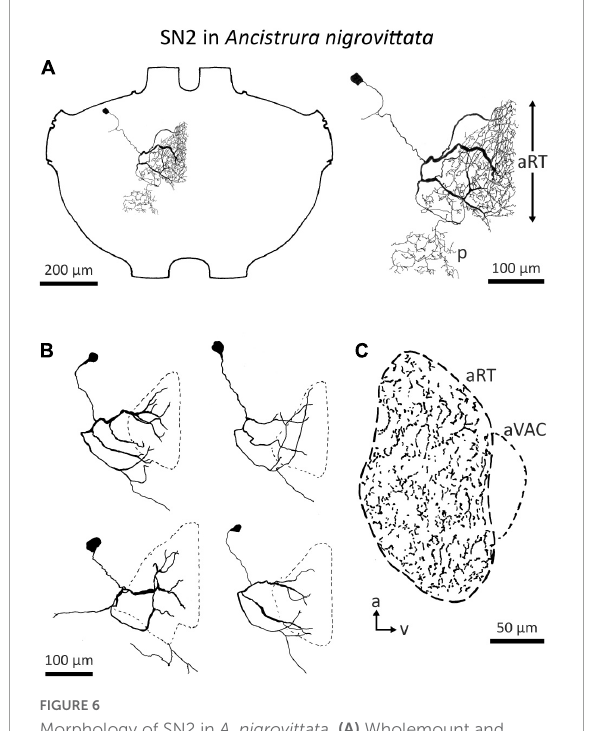
FIGURE6 Morphology of SN2 in A. nigrovittata . (A) Wholemount and detailed view of SN2 in a female. The extent of the anterior ring tract (aRT) is indicated by the arrows; the secondary branching area marked with p lies posterior and more laterally to the aRT. (B) Four examples of the main branches in two females (upper) and two males (lower). The extensions of the dendritic trees are indicated by a dashed line. (C) Parasagittal section (16 µ m) close to the midline showing the arborizations of SN2 in a female. The dashed line delimits the auditory neuropile, corresponding to aRT, the smaller dashed line on the ventral side indicates the anterior ventral association center (aVAC; e.g., Lakes and Schikorski,